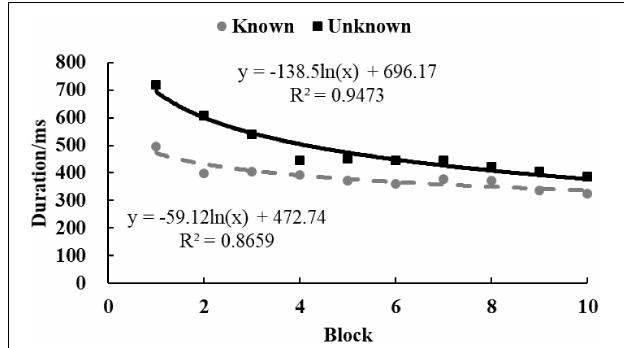
FIGURE 3 | The M of drawing time in Study 2. The solid and dotted lines represent the regression curves for the unknown and known conditions, respectively.